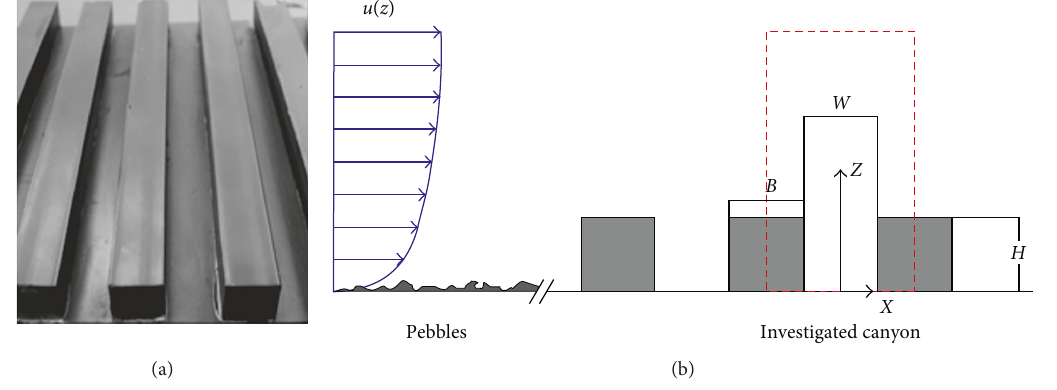
Figure 2: Obstacles set for AR � 1 (a). Sketch of the vertical section